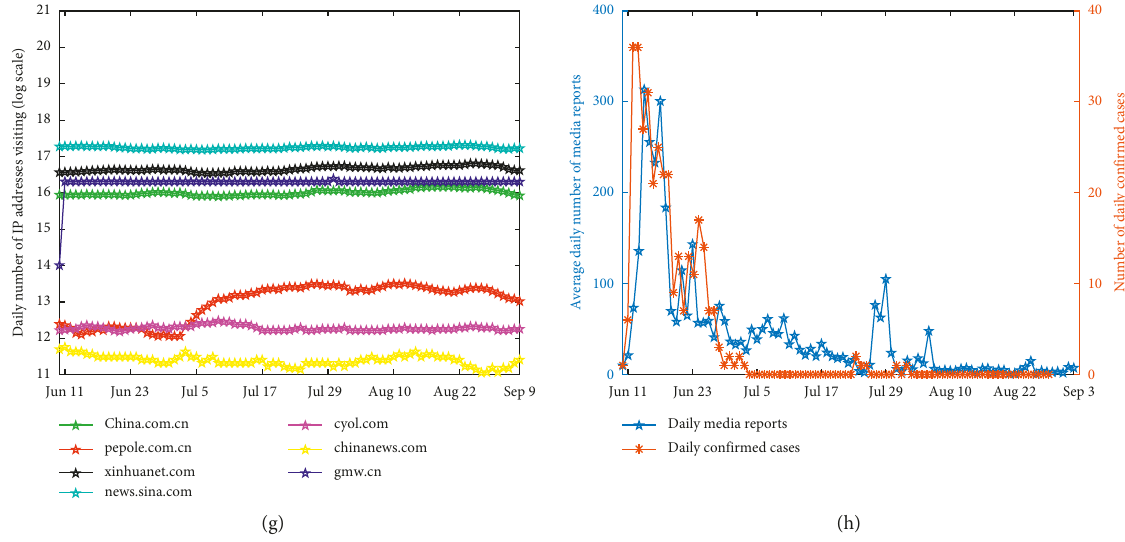
Figure 1: Cumulative number of confirmed cases and recovered cases from 20 January to 28 April 2020 (a) and from 11 June to 3 September 2020 (e); Number of daily media reports (b) and IP addresses (c) visiting xinhuanet.com, huanqiu.com, cnr.cn, and news.sina.com.cn, respectively; Number of daily media reports (f) and IP addresses (g) visiting China.com.cn, people.com.cn, xinhuanet.com, news.- reports from 20 January to 28 April (d) and from 11 June to 3 September